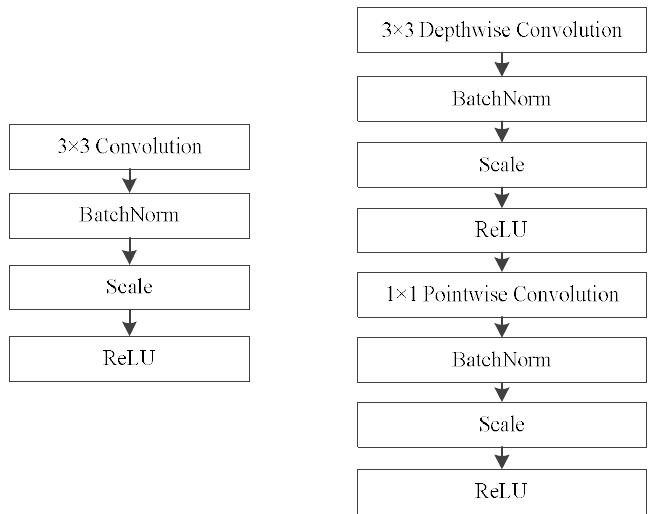
Figure 3. Standard convolutional filters in the top row are replaced by two layers: depthwise convolution in the bottom row, first column, and pointwise convolution in the bottom row, second column.